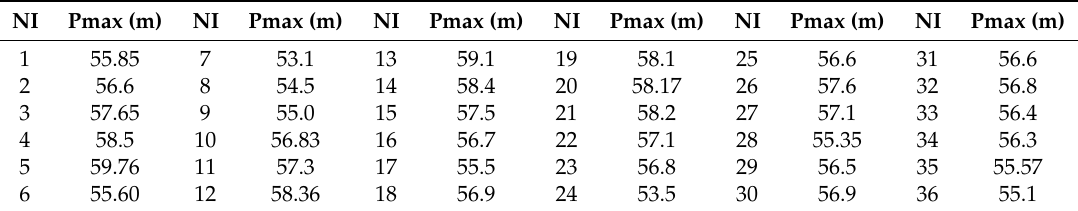
Figure 3. Layout of Fossolo network (FOS) [21]. Table 3. Maximum pressure head requirement of each node of Fossolo network (FOS).